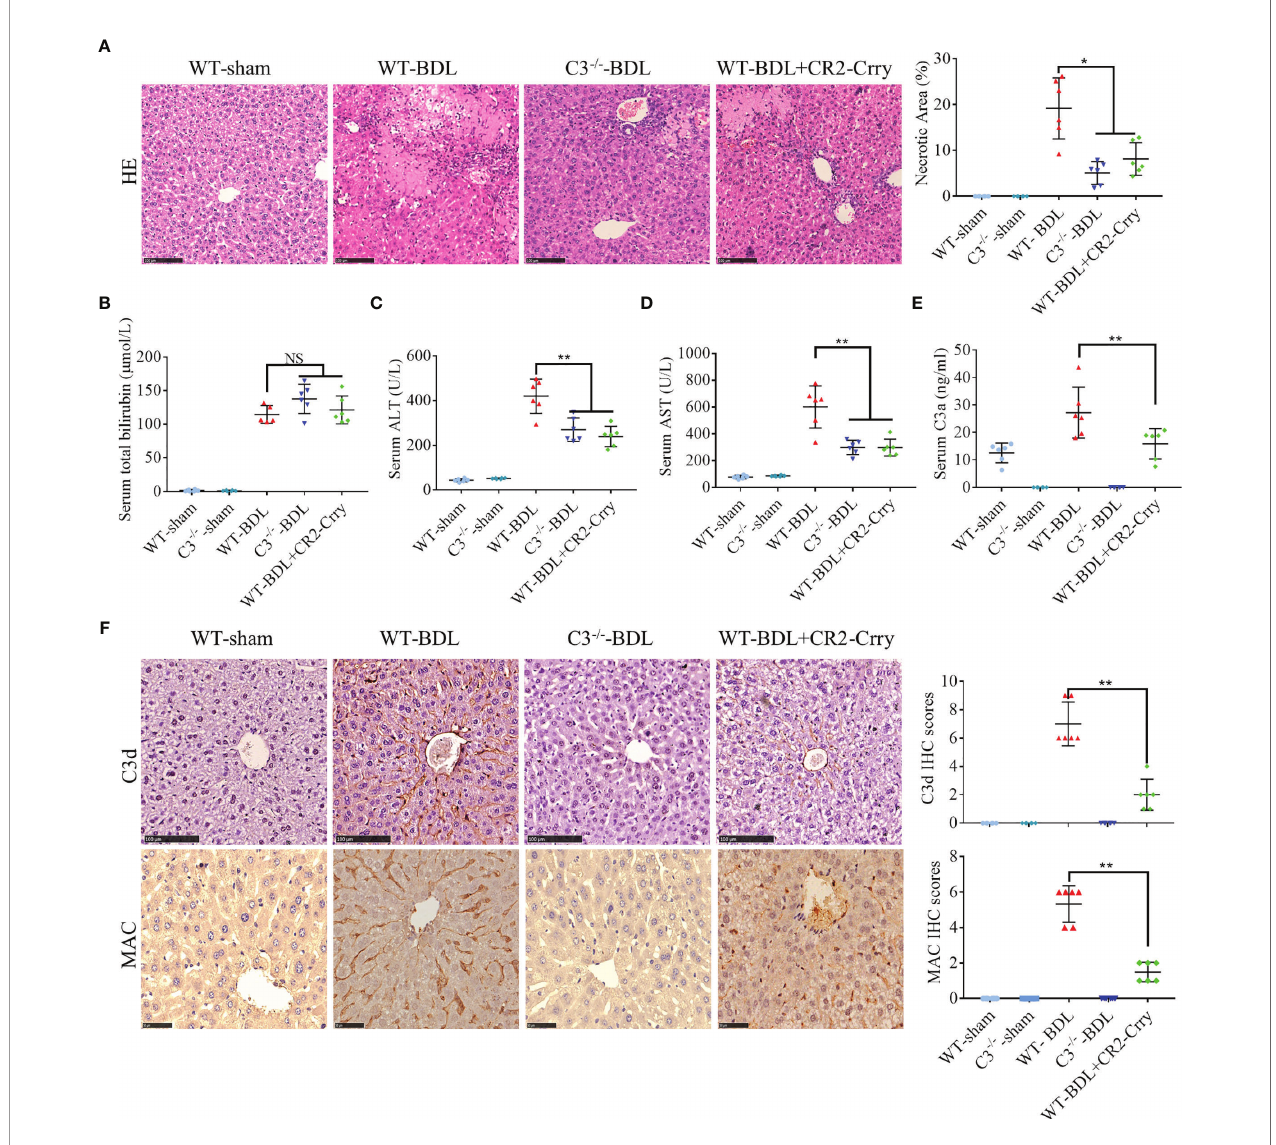
FIGURE 1 | Complement activation in CLI and alleviation of CLI by C3 de fi ciency or CR2-Crry in mice. Wild-type or C3 de fi cient mice were subjected to BDL or sham operations. WT-BDL mice were injected i.p. with PBS or CR2-Crry. The mice were sacri fi ced after 3 days and the samples were collected. Formalin- fi xed, paraf fi n- embedded liver sections were stained with HE or immunostained with antibodies to C3d and MAC. Liver function and C3 activation were measured in serum samples. (A) HE staining to assess liver necrosis (scale bar, 100 m m). (B – E) Serum concentrations of (B) total bilirubin, (C) ALT, (D) AST, and (E) C3a. (F) Immunostaining of liver samples for C3d (scale bar, 100 m m) and MAC (scale bar, 50 m m). Results are expressed as mean ± SD for 6 samples per group. *p < 0.05, **p < 0.01; NS, not signi fi